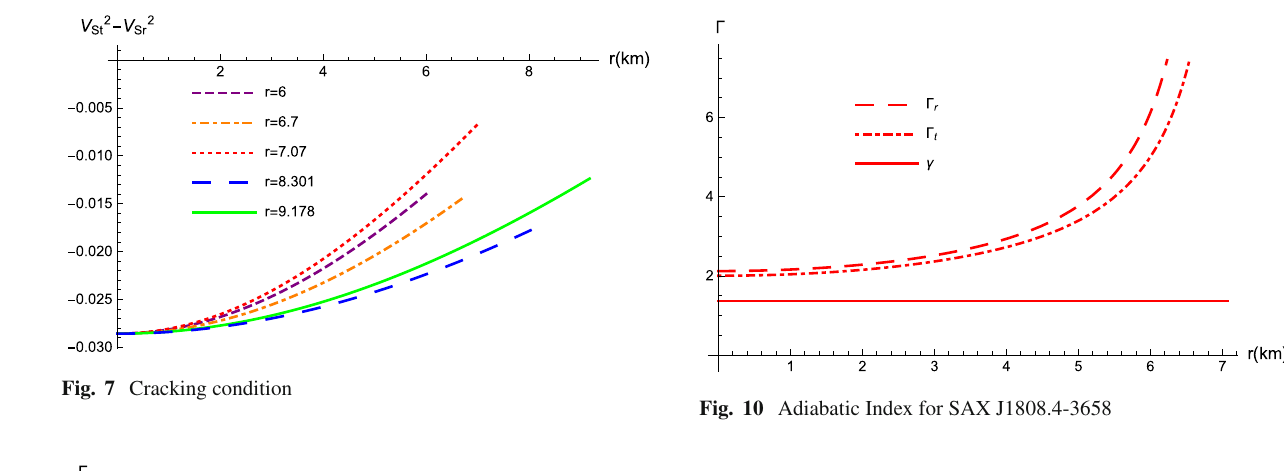
Fig. 6 Tangential speed of sound